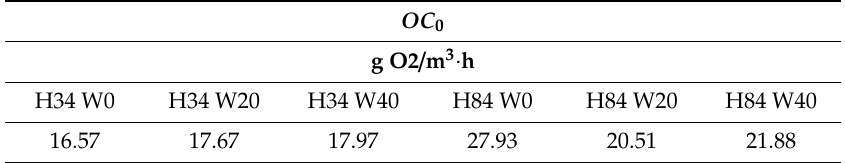
Table 1. Maximum oxygenation capacity of a barbotage reactor depending on nozzle pipe position H and moving bed filling